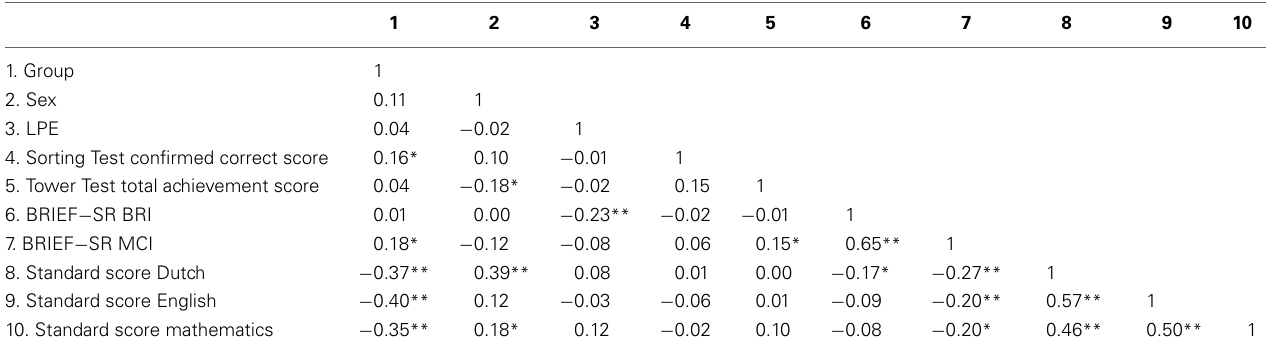
Table 2 | Zero-order correlations between background variables, executive function measures, and report